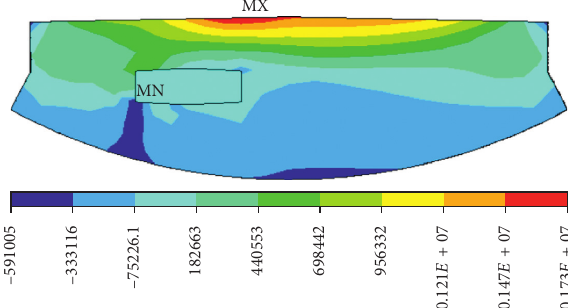
Figure 18: First principal stress of tunnel substructure (Pa) after the